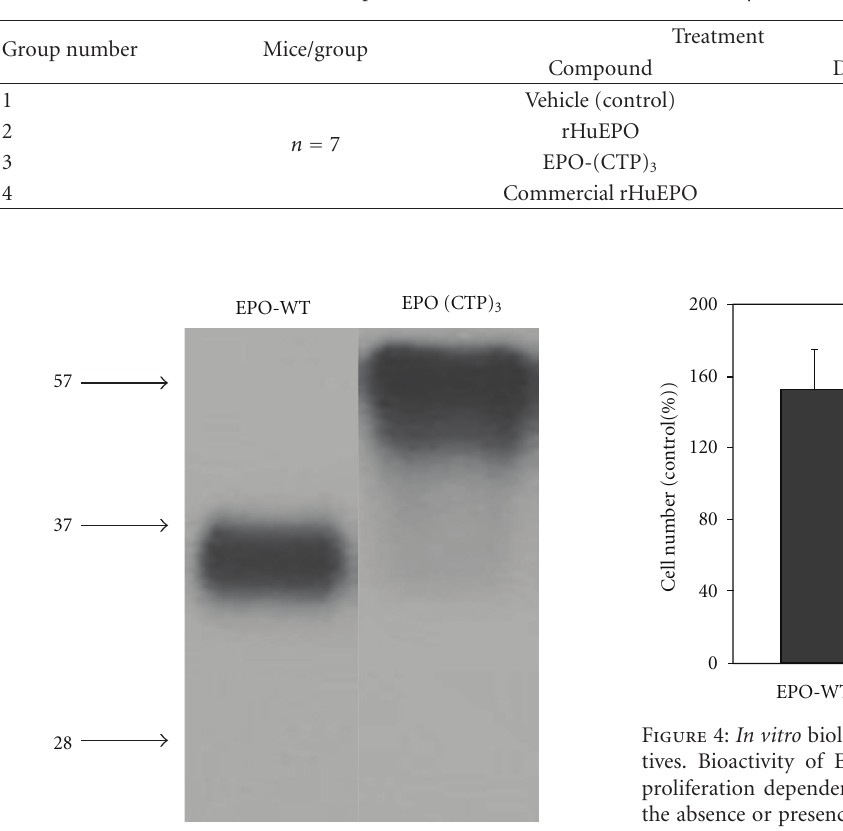
Figure 3: Expression of EPO-WT and EPO-(CTP) 3 from trans- fected CHO cells. Conditioned media from transfected cells were prepared for SDS/PAGE and proteins were detected by Western blot as described under “Materials and Methods.”